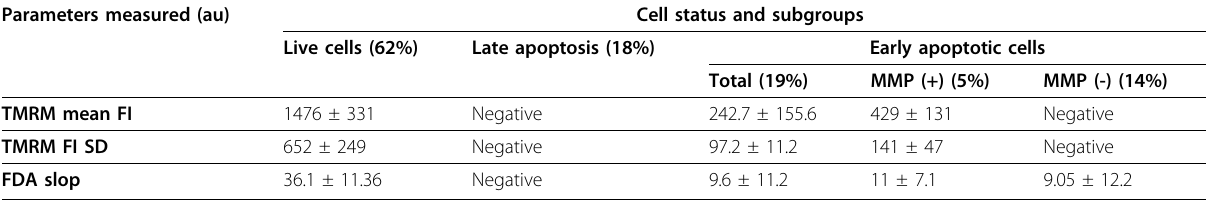
Table 4 U937 cells ’ functional status after the freezing - thawing cycle Parameters measured